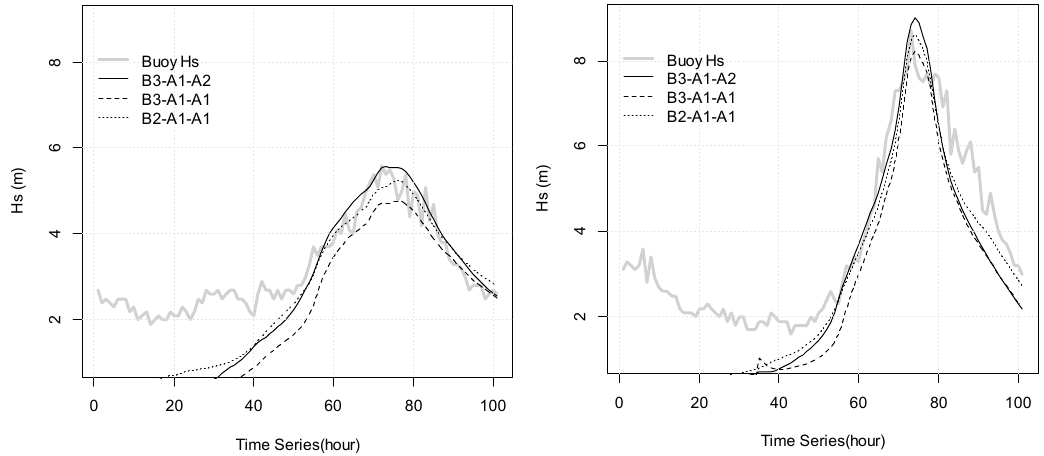
Figure 11. Simulation of wave height at buoys QF301 (left) and QF303 (right) during typhoon Nesat (172011): the standard H10 is indexed as B2-A1-A1, the model with varying parameter b without an asymmetric typhoon structure is indexed as B3-A1-A1, and MH10 is indexed as B3-A1-A2.